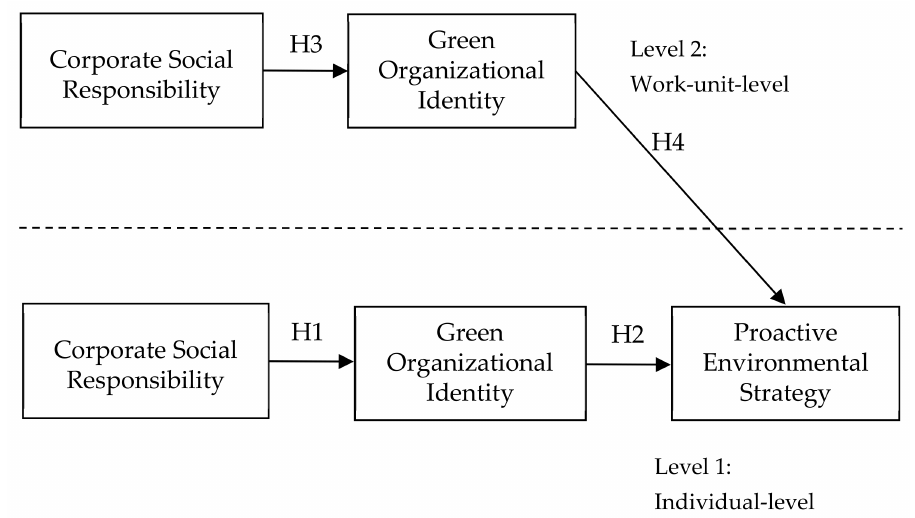
Figure 1. Research model of this